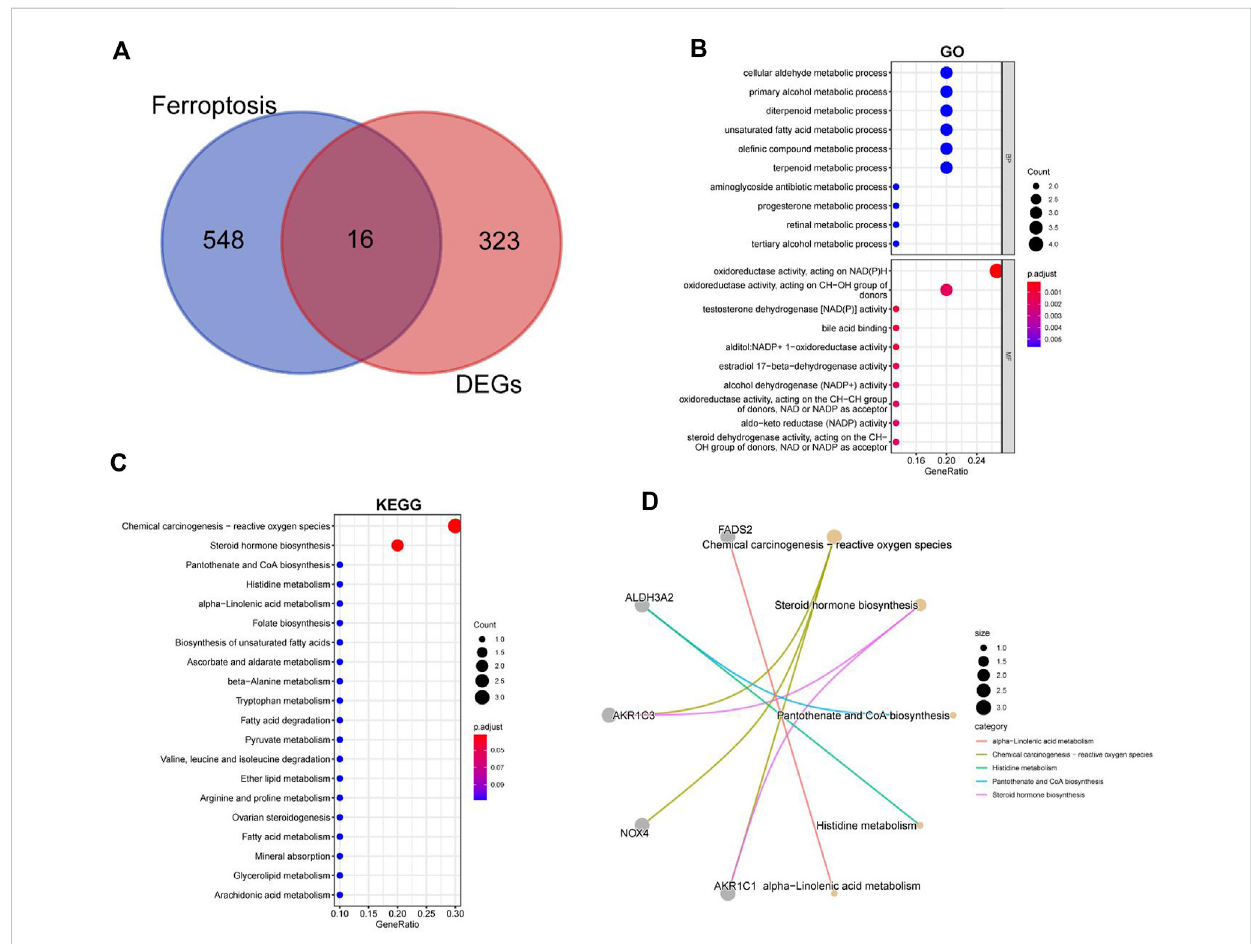
FIGURE 4 GO and KEGG enrichment analysis for the ferroptosis-related DEGs. (A) Intersection of ferroptosis-related genes and IDD-related genes. (B) GO terms enriched by the differentially expressed ferroptosis-related DEGs. (C) KEGG pathways enriched by the differentially expressed ferroptosis-related DEGs. (D) The relationship between KEGG results of top5 and its related